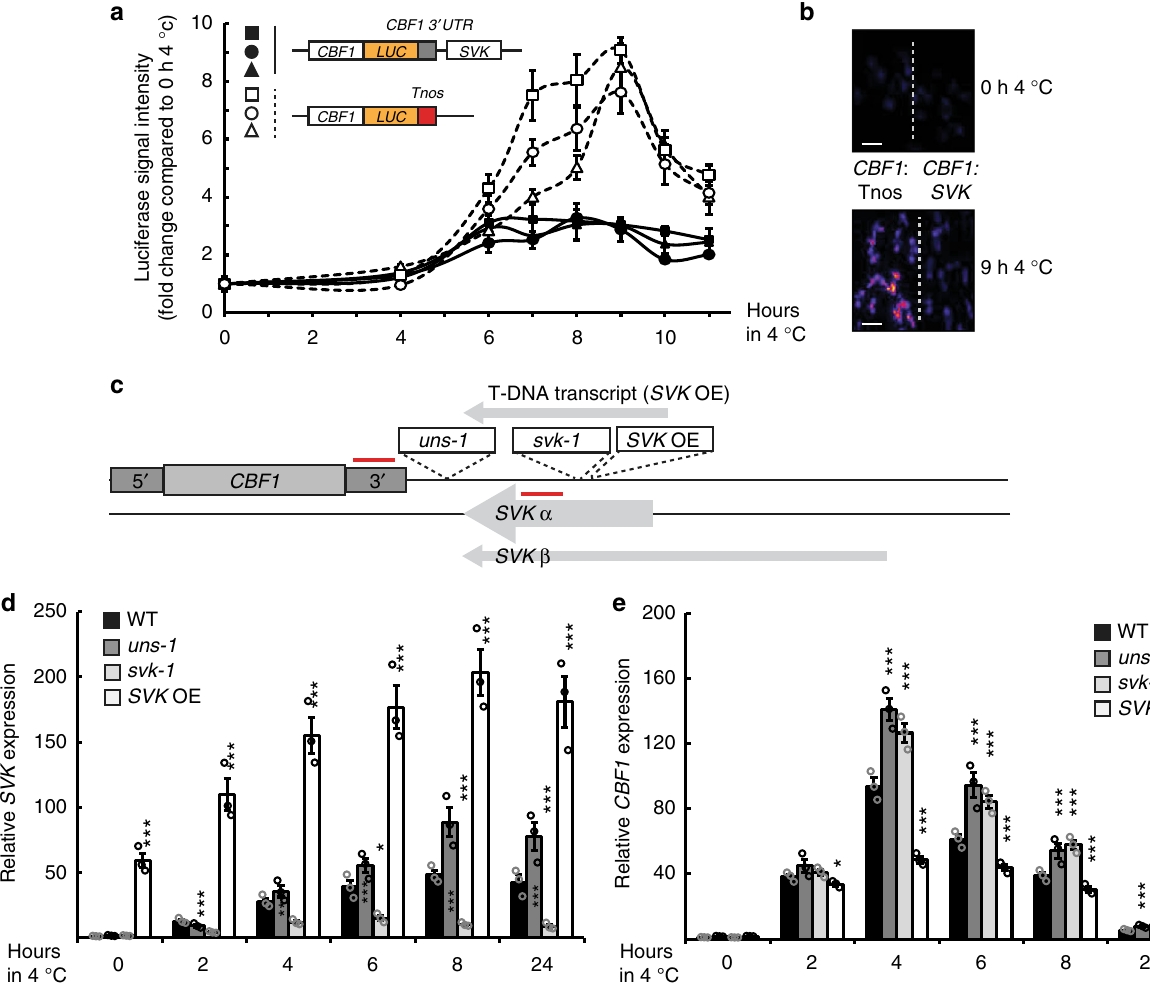
Fig. 2 Characterization of the long non-coding RNA, SVALKA . a LUCIFERASE (LUC) activity of two different CBF1 - LUC constructs. White markers indicate three independent transformants of a construct where LUC expression is driven by the CBF1 promoter and terminated by the T NOS terminator (CBF1:T NOS ). Black markers indicate three independent transformants of constructs where LUC expression is driven by the CBF1 promoter with the endogenous CBF1 terminator and full SVALKA sequence (CBF1:SVK). The CBF1:SVK lines showed a decreased LUC activity following cold exposure compared to the CBF1: T NOS ) lines. LUC activity was measured as average pixel intensity of at least 5 seedlings for each time point. Markers represent mean with standard deviation. Source data are provided as a Source Data fi le. b Representative images of lines in control conditions and after 9 h of cold exposure for the two LUC constructs. Scale bar represents 1 cm. c Graphical representation of the insertion positions of the T-DNA lines used in this study. The qPCR probes are indicated with red and used in ( d ) and ( e ). See Supplementary Figure 5 for additional information on the insertion mutants. d , e Relative SVK ( d ) and CBF1 ( e ) expression determined by RT-qPCR in WT and mutants that effect SVK following exposure to cold. Bars represent mean (black: WT, dark grey: uns-1 , light grey: svk-1 , white: SVK OE , ±SEM) from three biological replicates (rings). The relative level of SVK and CBF1 transcripts were normalized to the level in WT in control conditions. Statistically signi fi cant differences between means were determined with Student ’ s t -test (* p < 0.05, *** p < 0.001). Source data are provided as a Source Data fi